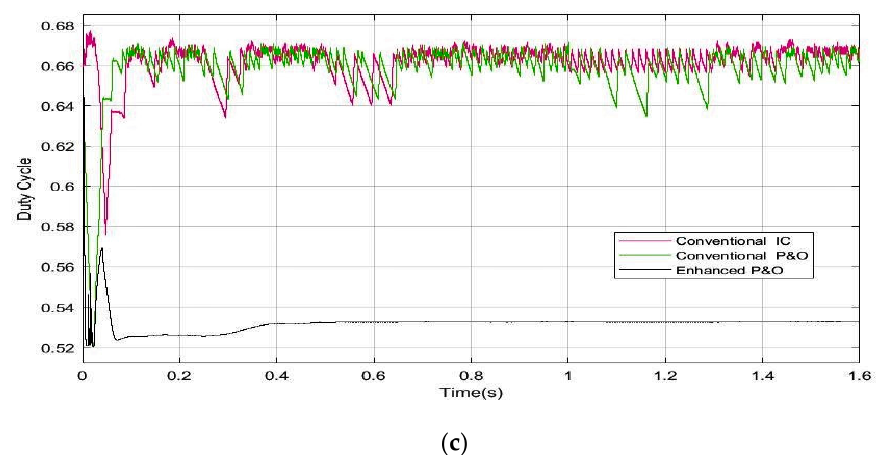
Figure 8. The simulation results of the proposed technique and the conventional P&O and incremental conductance (IC) techniques for Case One: ( a ) Tracked output power; ( b ) Output voltage of the boost converter; ( c ) Duty cycle behaviors.